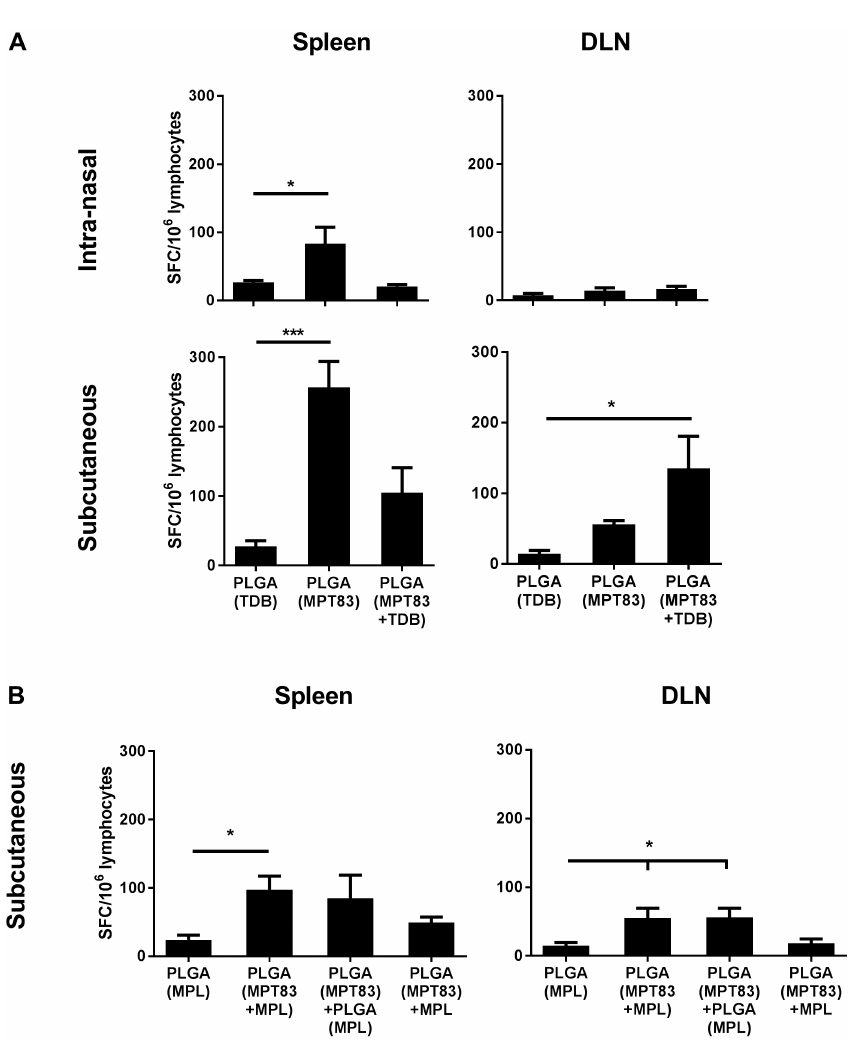
Fig 1. Antigen-specific IFN γ -secreting cells were induced systemically following immunisation with PLGA particulate vaccines. C57BL/6 mice were immunised with 1 mg PLGA vaccine either i.n or s.c as indicated, three times at two-weekly intervals. At four weeks after the last vaccination, lymphocytes of vaccinated mice were stimulated ex vivo with MPT83 (10 μ g/ml). The numbers of MPT83-specific IFN γ -secreting cells/10 6 lymphocytes in the spleen or DLN of mice immunised with PLGA vaccines adjuvanted with (A) TDB or (B) MPL were enumerated by ELISPOT after 20 hr antigen stimulation. The data are the means ± SEM (n = 3) and are representative of two independent experiments. Statistical significance was calculated by ANOVA with Bonferroni post-hoc comparison to adjuvant only control ( (cid:3) p < 0.05, (cid:3)(cid:3)(cid:3) p < 0.001).